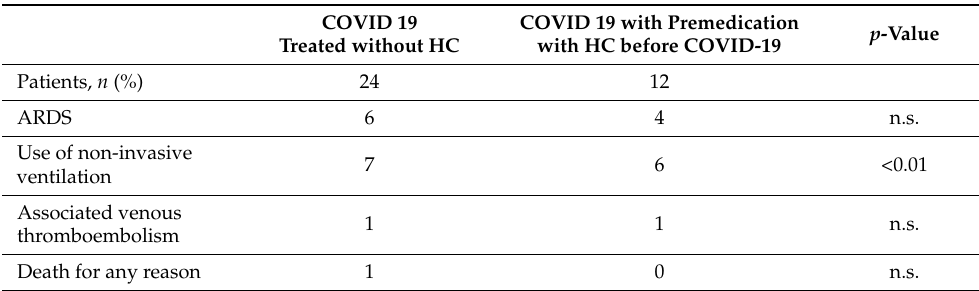
Table 4. Clinical evolution in patients with COVID-19 with and without pre-medication with hydroxychloroquine. COVID 19 COVID 19 with Premedication Treated without HC with HC before